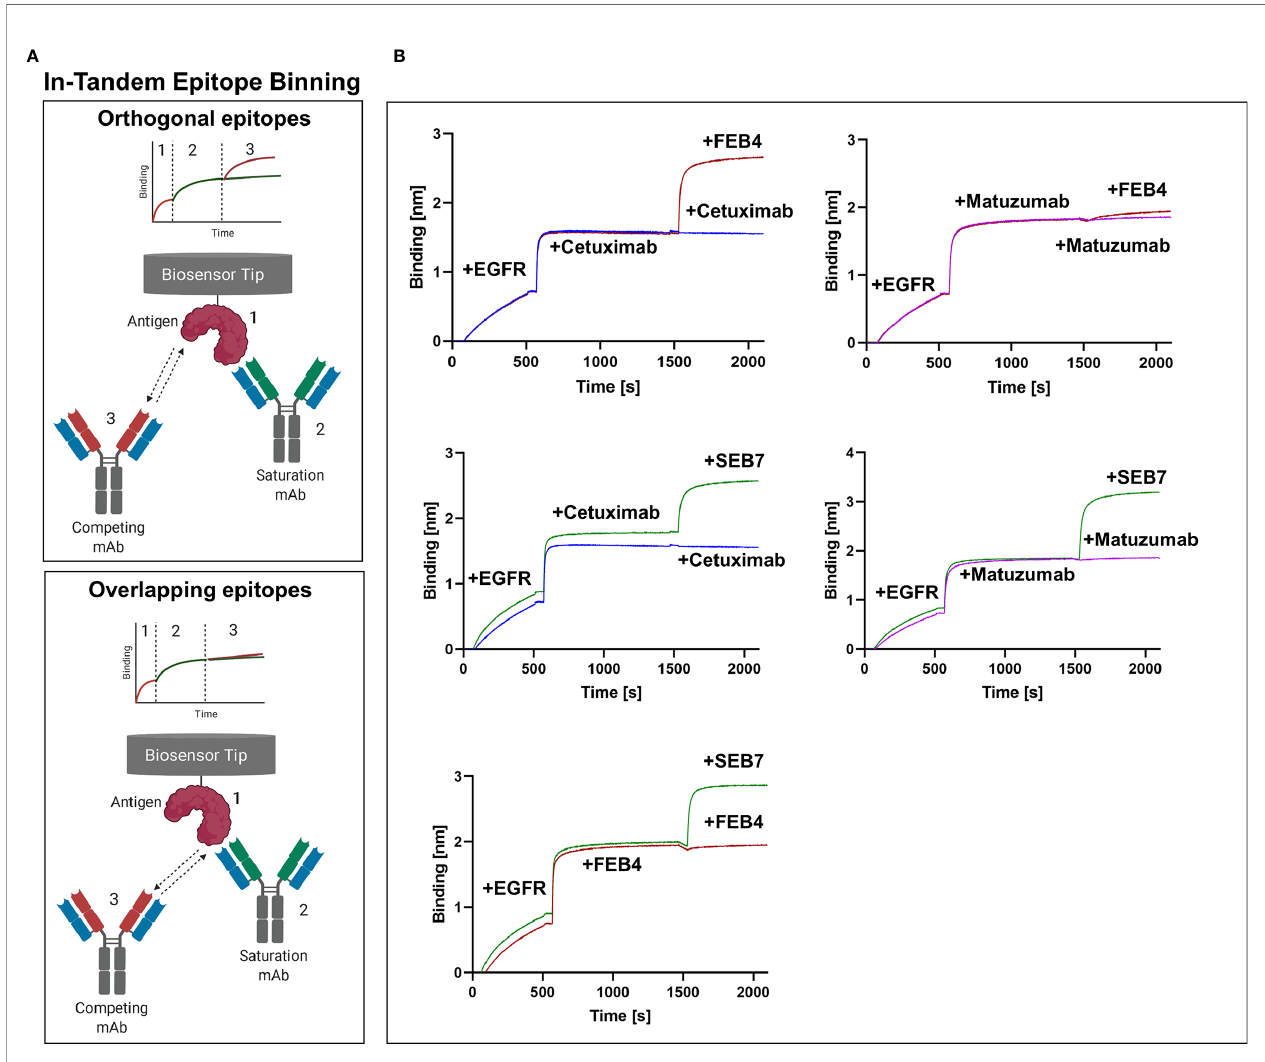
FIGURE 2 | Epitope binning of FEB4 and SEB7. (A) Schematic representation of epitope binning in-tandem setup. His-tagged antigen is loaded onto Ni-NTA biosensors (1), followed by binding of the fi rst antibody until saturation is achieved (2). Subsequently, either the saturation antibody or the completion antibody is applied (3), resulting only in an increment of layer thickness if orthogonal epitopes are addressed. (B) BLI-based binning in-tandem setup investigating epitope recognition of FEB4 and SEB7. Ni-NTA tips were loaded with EGFR-ECD, followed by binding to the fi rst antibody of interest until saturation was achieved. Subsequently, either the second antibody was applied, or a new incubation of the fi rst antibody was performed, which served as control. Created with